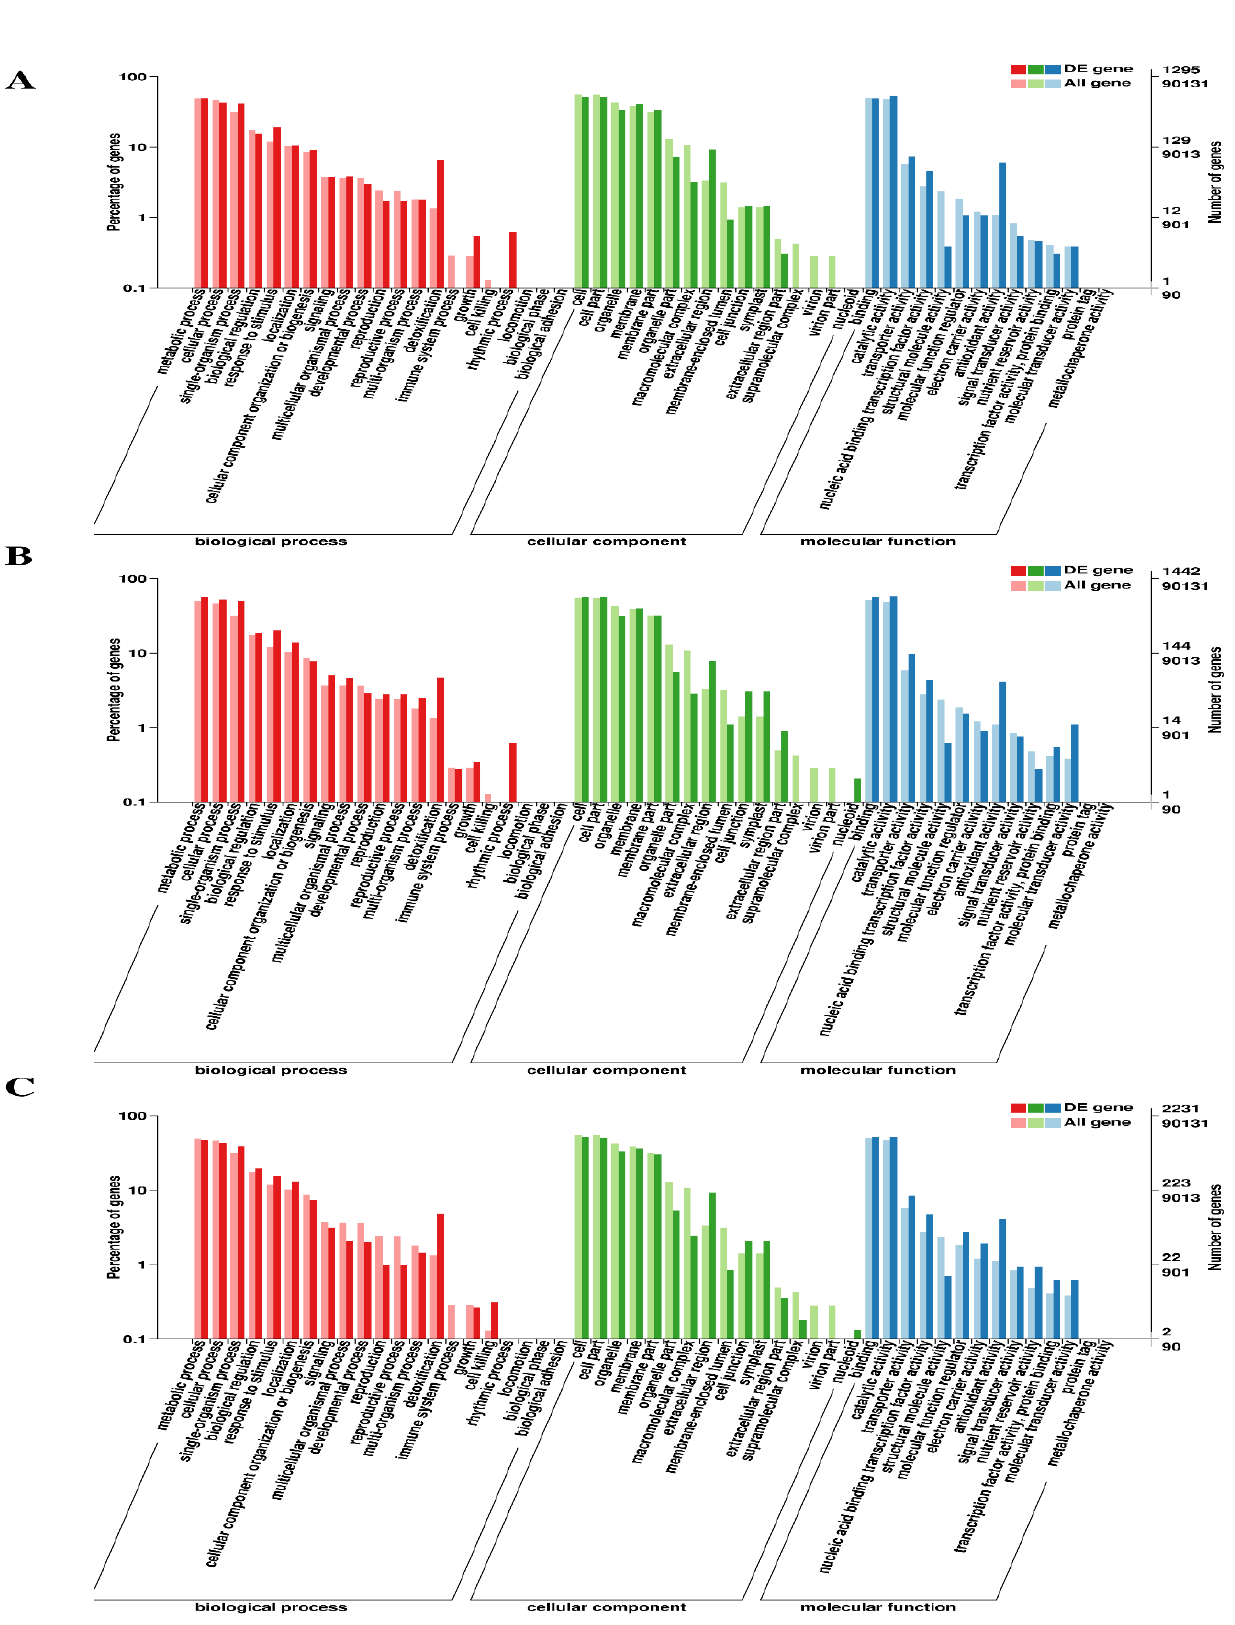
Figure 4. Functional classification of DEGs into different categories based on gene ontology (GO). The GO terms are classified into three main categories (biological process, cellular component and molecular function) and further into subcategories, which are indicated on the Y-axis. ( A ) At 7d of Cd stress; ( B ) at 14d of Cd stress; ( C ) at 30d of Cd stress.